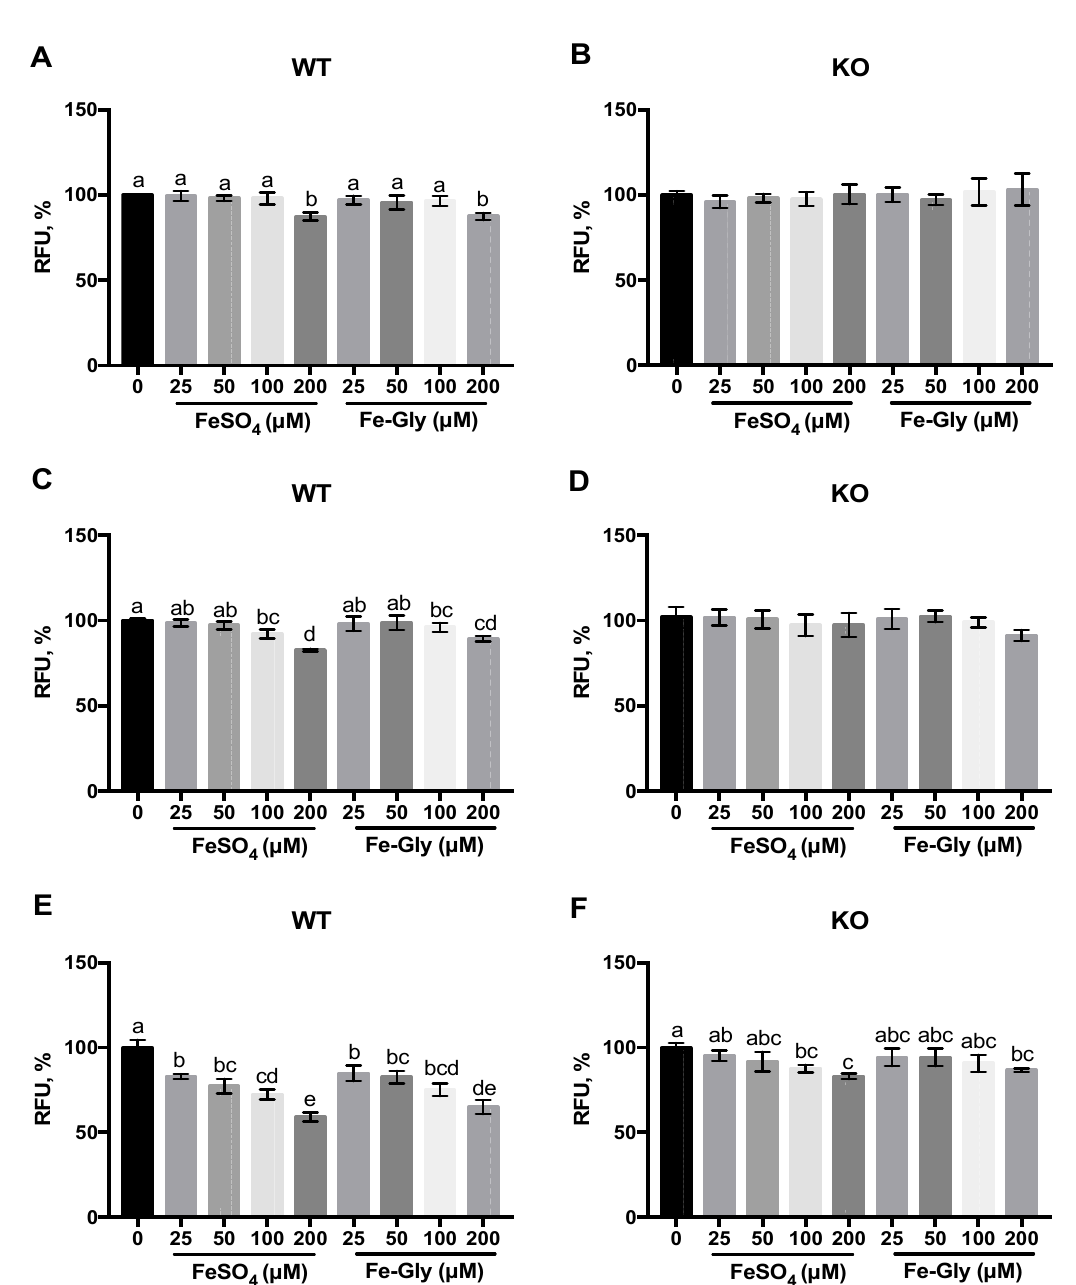
Figure 3. Changes of labile iron after treatment with different iron sources (0, 25, 50, 100, 200 µ M) in wild-type cells and DMT1-knockout cells. Values not sharing a common letter differ significantly ( p < 0.05). WT: wild-type Caco-2 cell; KO: DMT1-knockout Caco-2 cell; RFU: relative florescence unit. Changes of labile iron after 0.5 h ( A , B ), 1 h ( C , D ), 2 h ( E , F ) treatment with different iron sources in wild-type cells and DMT1-knockout